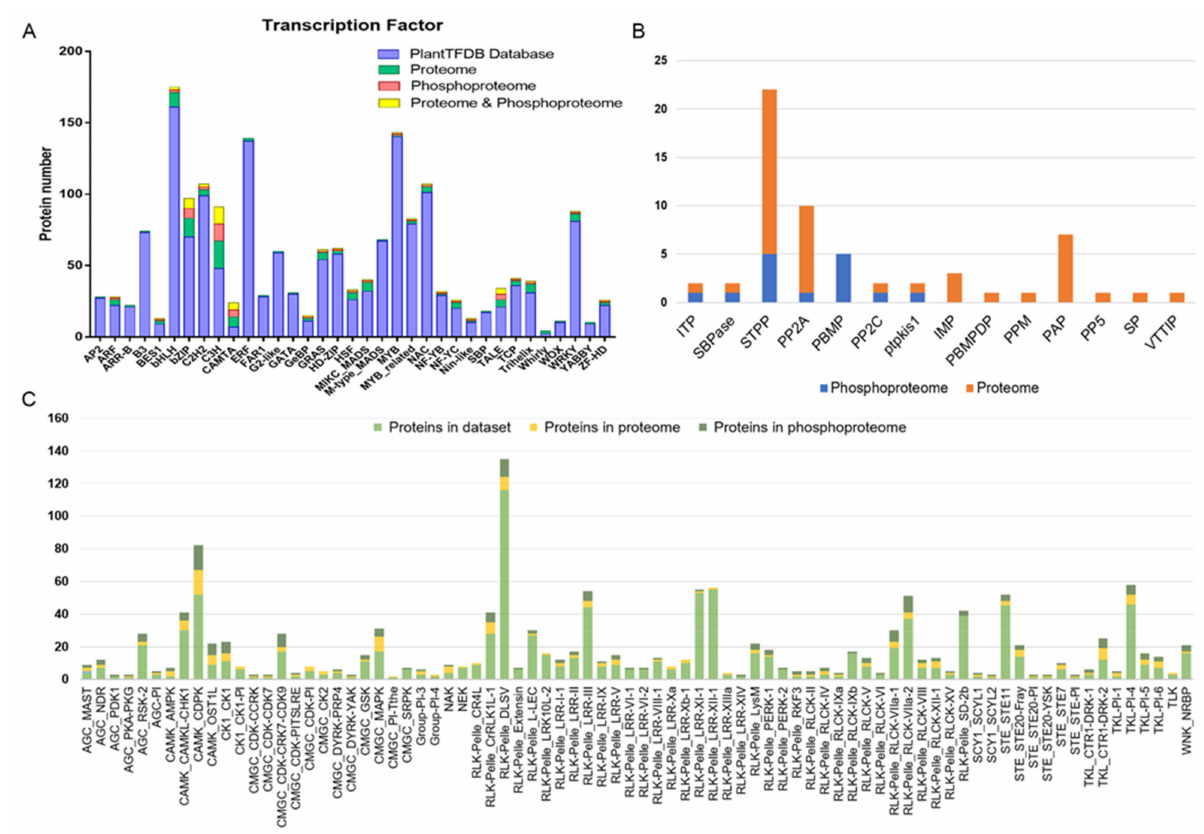
Figure 7. Distribution of transcription factors, phosphatase and protein kinases annotations in the two omics’ profiles and tomato databases. ( A ) Transcription factors, ( B ) phosphatase and ( C ) protein